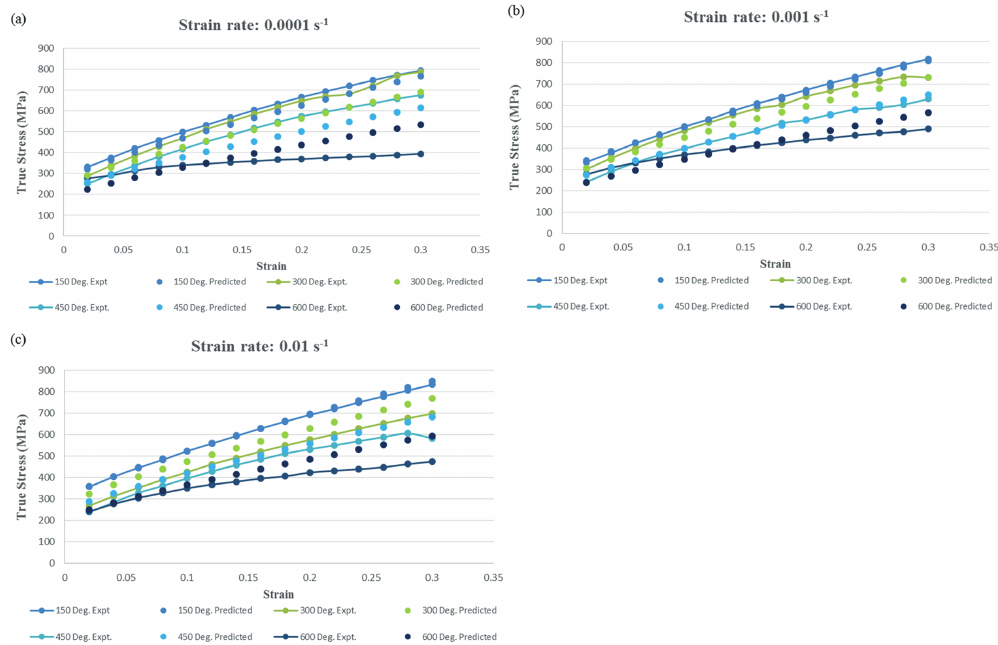
Figure 5: Comparisonofexperimentalandpredictedflowstressfor KHL modelforASS304forstrainratesof(a)0.0001s − 1 (b)0.001s − 1 (c)0.01s − 1